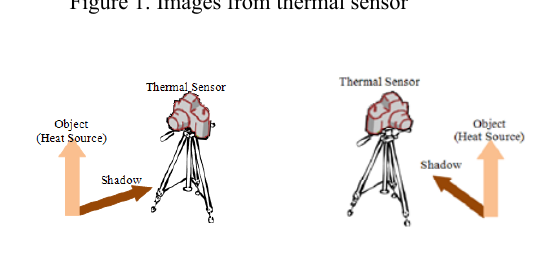
Figure 1. Images from thermal